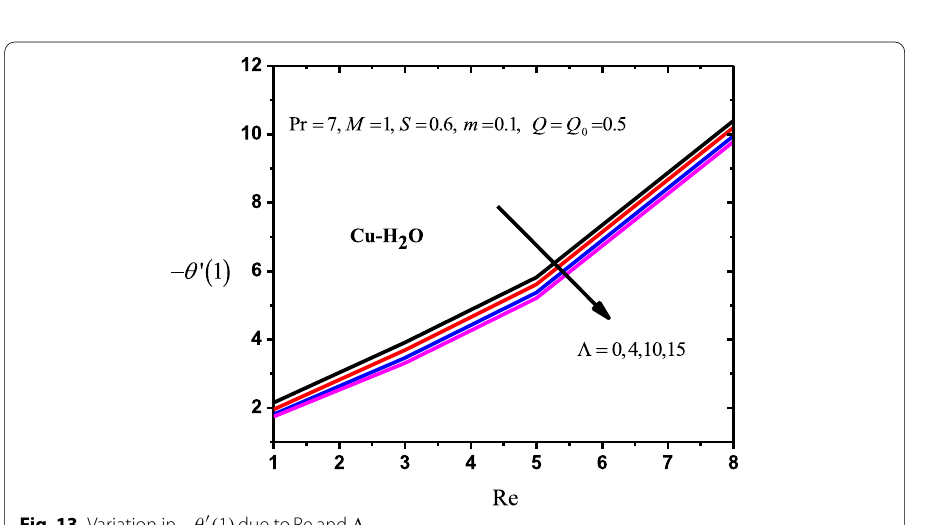
θ ′ ( 1 ) due to Re and −